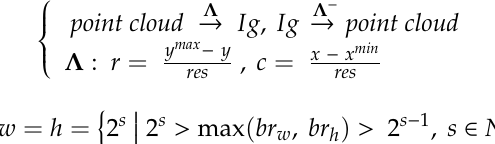
( d ) Figure 5. Simplification results of plane point cloud: ( a ) original plane point cloud, ( b ) boundary point cloud in green, ( c ) grayscale image, and ( d ) simplified plane point cloud ( (cid:1842)(cid:1864) (cid:3036)(cid:3046) ). 3.4. Feature Triangulation After the planar simplification, we reconstructed the model representation of the planar feature using different triangulation strategies in the interior and boundary of each (cid:1842)(cid:1864) (cid:3036)(cid:3046) . In the interior, a simple triangulation was performed, in which two triangles were directly generated based on the four corners of (cid:1835)(cid:1871)(cid:1868) (cid:3036)(cid:3020) . At the boundary, a vertex-assignment triangulation (Figure 6) was performed, and four rules were proposed for the triangulation process.